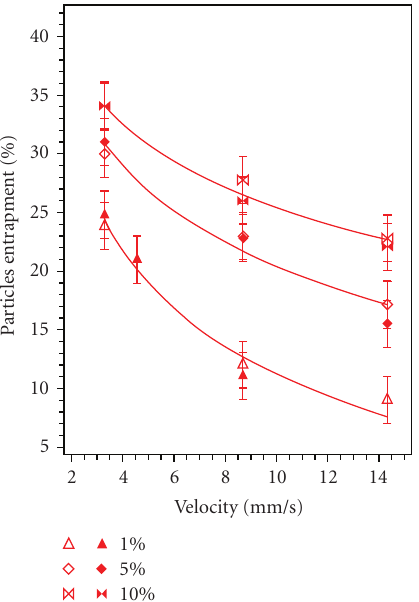
Figure 7: Entrapment of triestearin-magnetite (void symbols) and triestearin-phosphatidylcholine-magnetite (full symbol) particles as a function of fluid velocity and concentration of magnetite in the initial